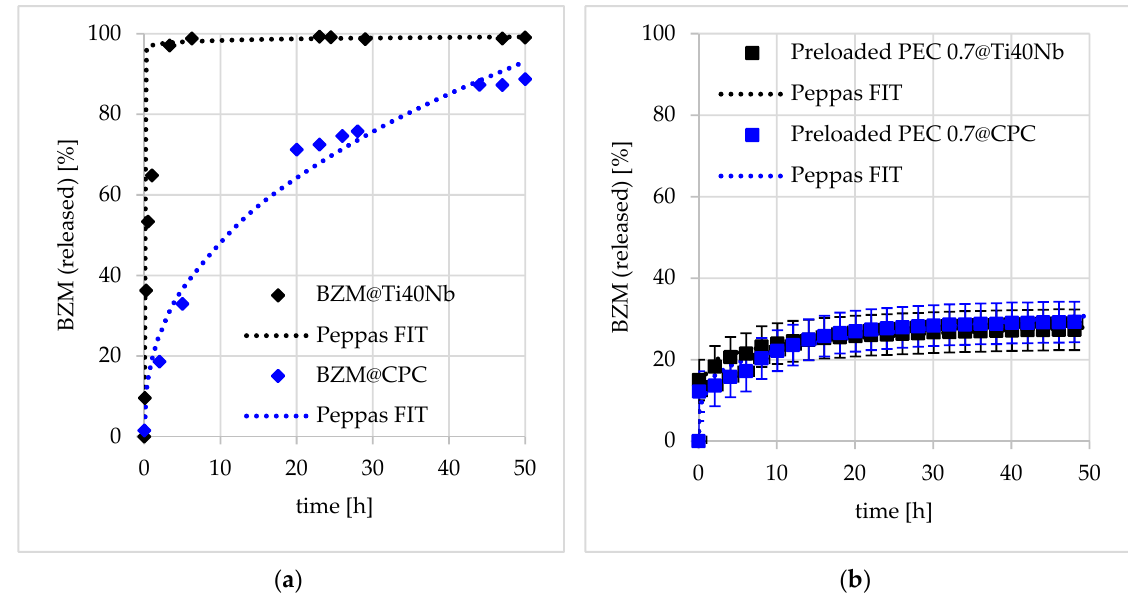
Figure 14. Release kinetics of ( a ) pure BZM coating and ( b ) BZM loaded PDOPAC / PEC coating at Ti40Nb as well as CPC (calcium phosphate cement).